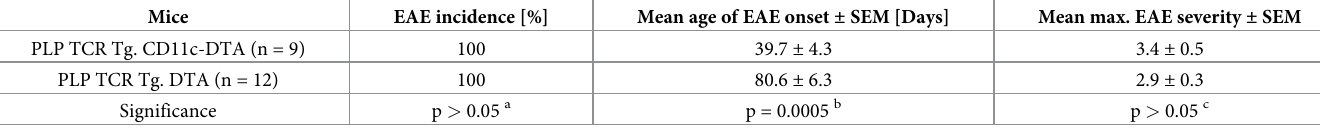
Table 1. Spontaneous EAE in DC deficient PLP TCR transgenic CD11c-DTA SJL mice.